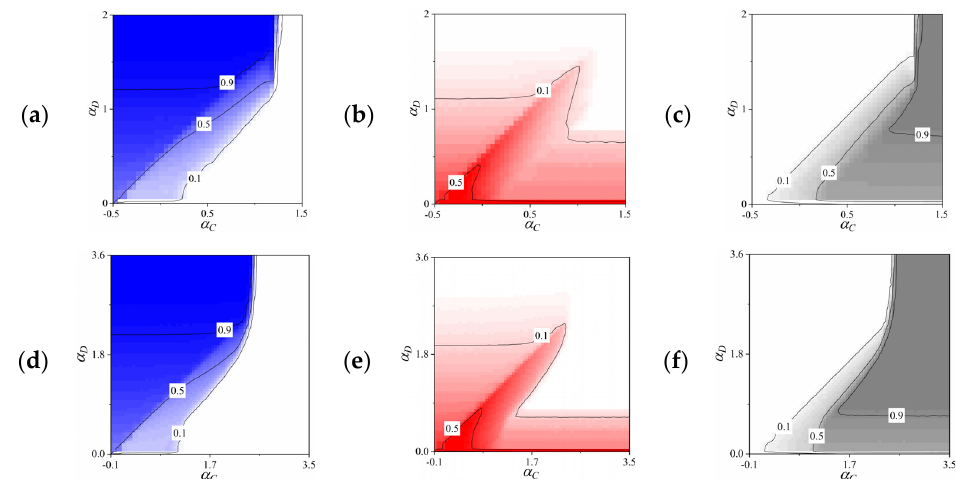
Figure A1. Fractions of cooperators (blue), defectors (red), and loners (gray) as functions of cooper- ators’ and defectors’ weights ( 𝜔 (cid:3004) and 𝜔 𝐷 ) in a single game for ( a – c ) 𝑟 = 2.5 and ( d – f ) 𝑟 = 4.5 . The other parameters are the same as in Figure 4.